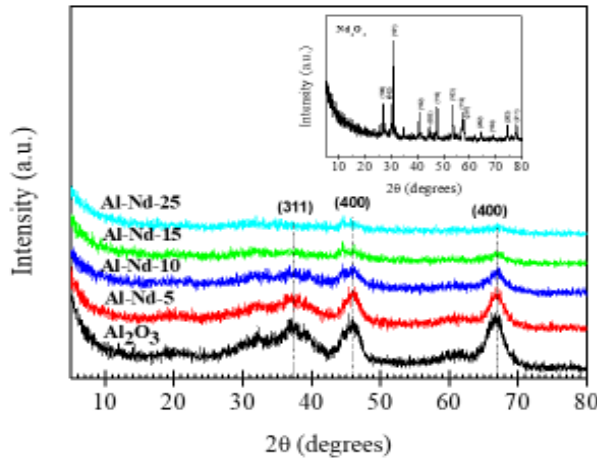
Figure 2. XRD patterns of γ -Al 2 O 3 and Al-Nd- x binary oxides prepared by the sol-gel method.